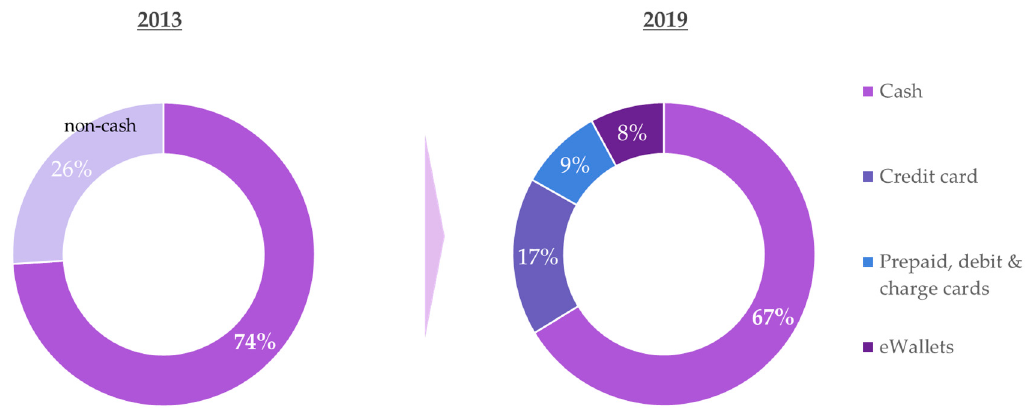
Figure 2. Cash versus non-cash payments in the UAE, 2013 and 2019. In percent value of total point-of-sale payments (Mastercard 2013; FIS 2020).